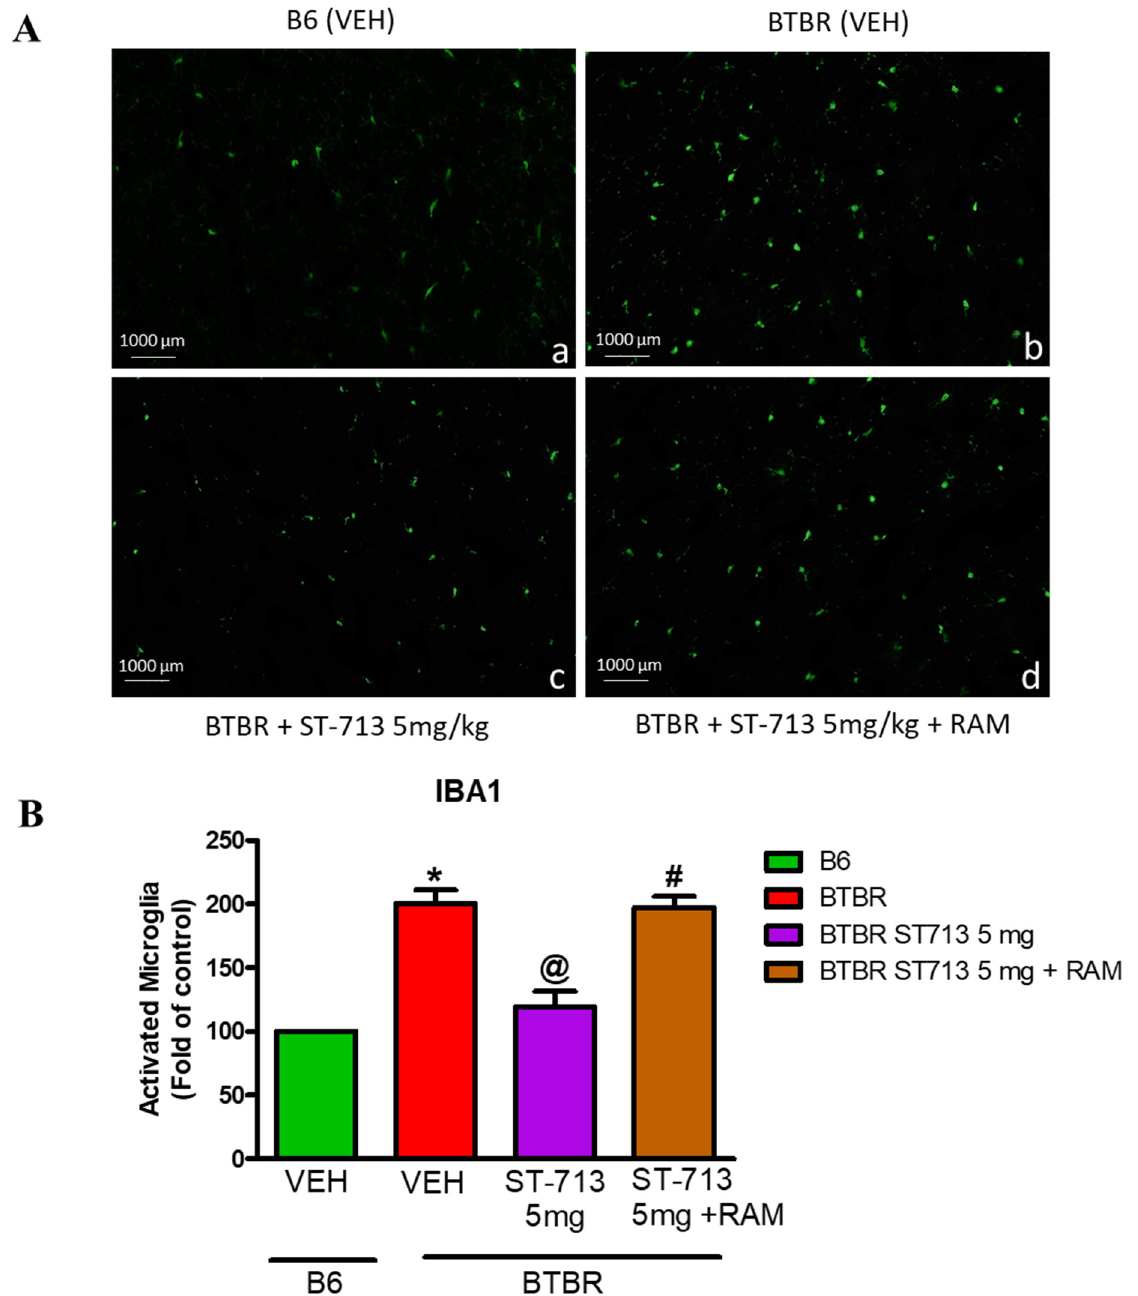
Figure 4. ST-713 inhibited microglia activation in BTBR mice. Immunofluorescence staining of iba-1-positive microglial cells in the brain sections of experimental B6 and BTBR mice. ( A ) (a,b) B6, BTBR VEH-treated mice (c) ST-713 (5 mg/kg) administered to autistic mice (d) ST-713 (5 mg/kg) co-administered with RAM (10 mg/kg) to BTBR mice. The densitometric evaluation for activated microglia was performed with ImageJ. ( B ) VEH-treated BTBR mouse brain shows significantly increased levels of iba-1-positive activated microglial cells compared to VEH-treated B6 mice. Chronic systemic pretreatment with ST-713 (5 mg/kg) in BTBR mice significantly reduced the level of iba-1-positive activated microglial cells compared to VEH-treated BTBR mice. Chronic co-injection with RAM (10 mg/kg) abolished the beneficial outcomes provided by a 5 mg/kg dose of ST-713. The bar diagram represents percentage mean of three samples ± SEM (n = 3); * ( p < 0.05) vs. VEH-treated B6; @ p < 0.05 vs. VEH-treated BTBR group; # p <0.05 vs. ST-713 (5 mg/kg).